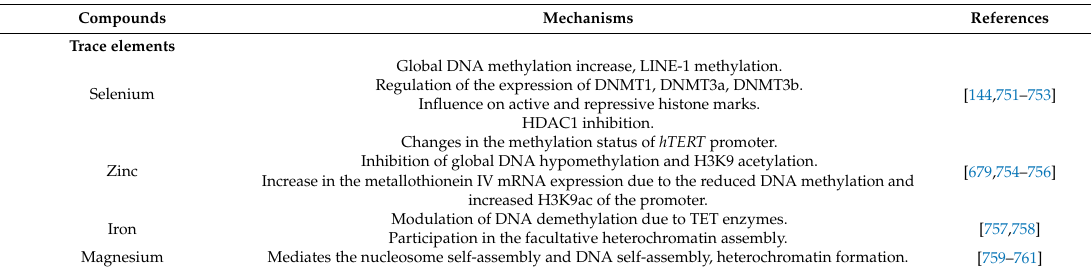
Table 3. Compounds preventing DNA damage due to epigenetic regulation, telomere maintenance, and nuclear architecture